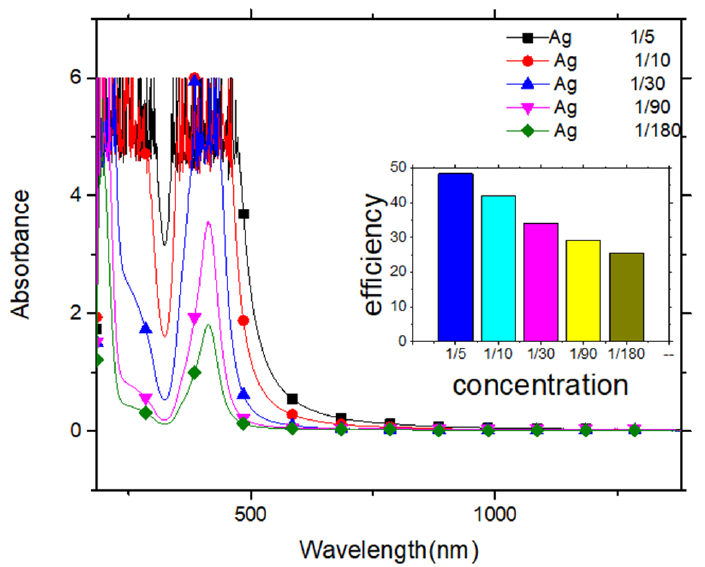
Figure 11. Absorption spectra of silver nano–solutions with different concentrations and prediction of solar energy absorption efficiency.